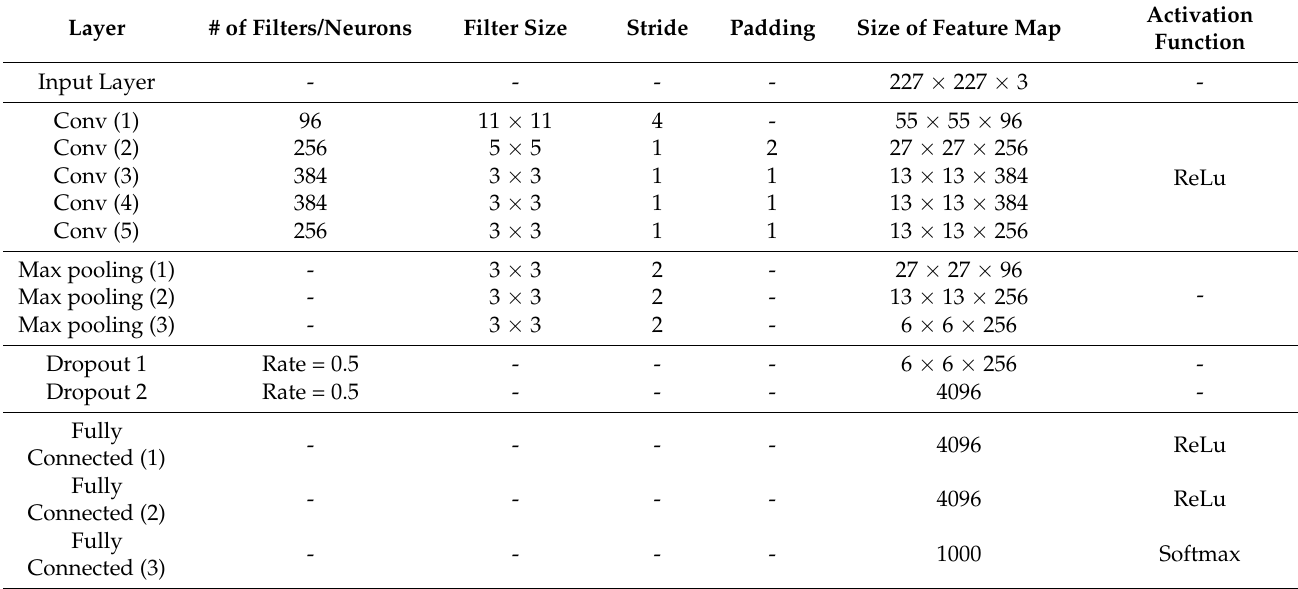
Table 1. The original AlexNet model architecture.